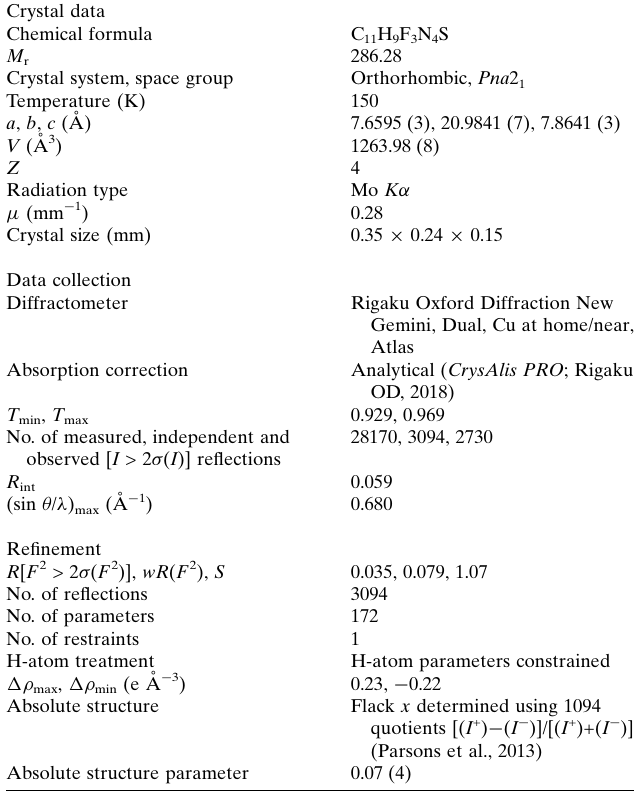
Crystal data Chemical